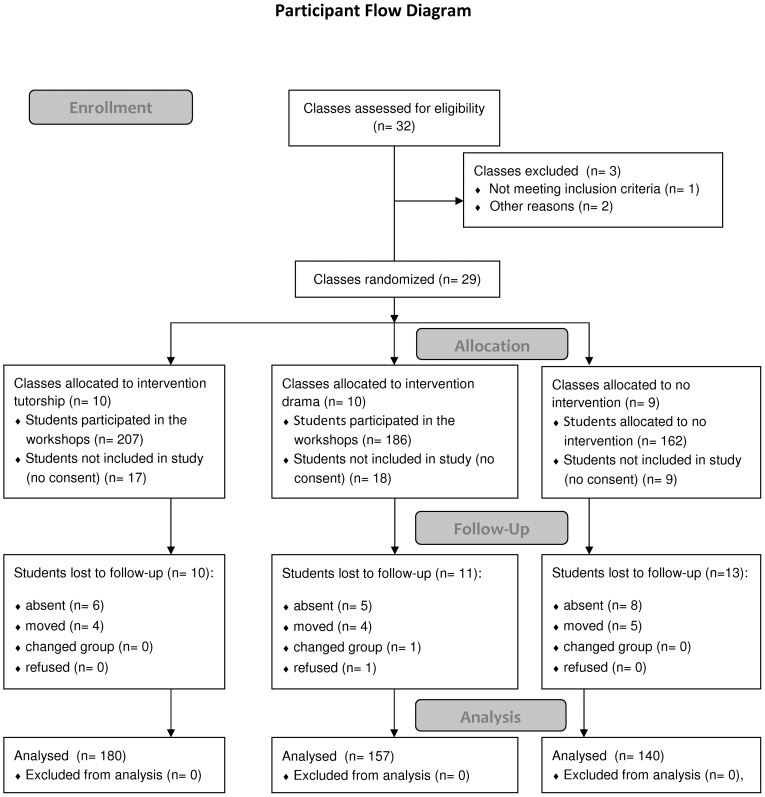
Participant Flow Diagram.